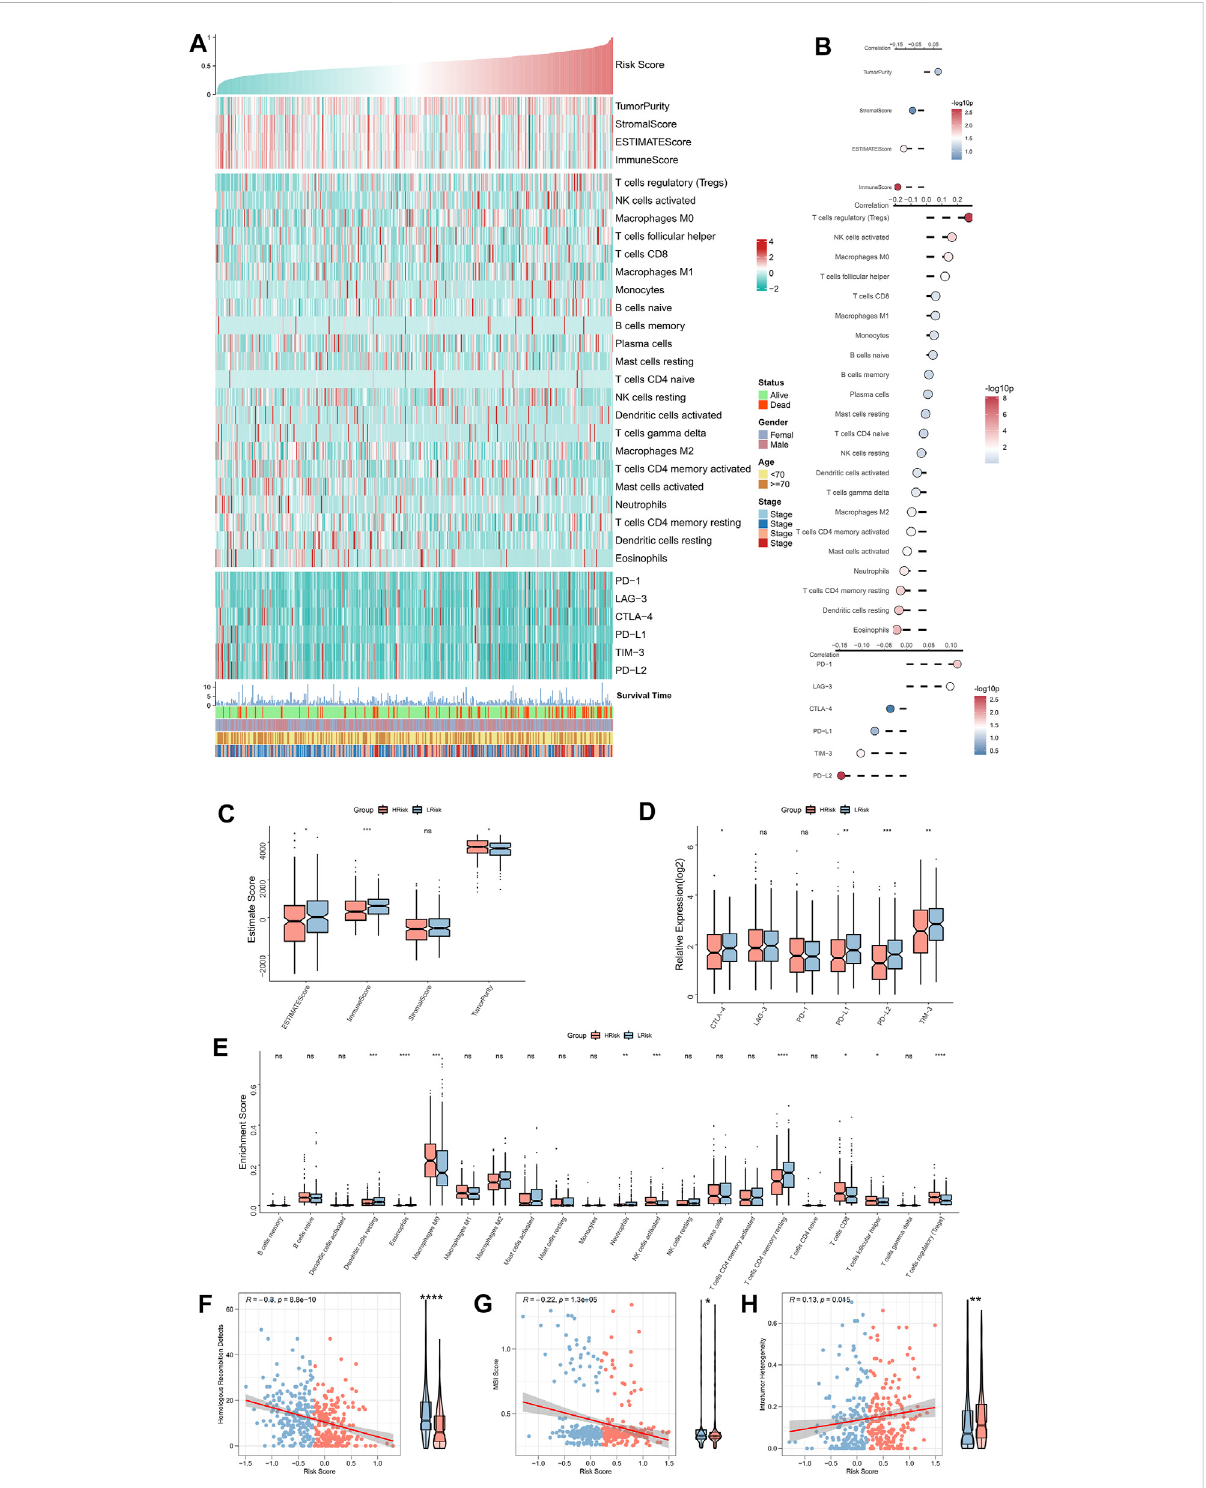
FIGURE 5 ImmunelandscapeoftheNRG-relatedriskmodel. (A) .HeatmapshowingthecorrelationbetweenRiskScore,EstimateScore,theabundanceof immunecellin fi ltration,immunecheckpointexpression,andclinicalcharacteristics; (B) .Fromtoptobottom:correlationanalysisbetweenRiskScore andEstimateScore,immunecellin fi ltrationabundance,andimmunecheckpointexpression; (C) .Boxplotshowingthedifferencesintheabundances ofimmunecellin fi ltrationsbetweenthehigh-riskandlow-riskgroups; (D) .BoxplotshowingthedifferencesinEsimateScorebetweenthehigh- risk and low-risk groups; (E) . Box plot showing the differences in immune checkpoint expressions between the high-risk and low-risk groups; (F) . Correlation between RiskScore and HRD scores; (G) . Correlation between RiskScore and MSI scores; (H) . Correlation between RiskScore and intratumor heterogeneity scores. * p < 0.05; ** p < 0.01; *** p <